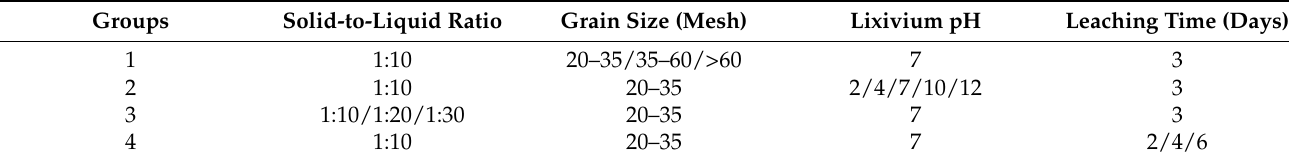
Table 3. Static leaching test scheme.